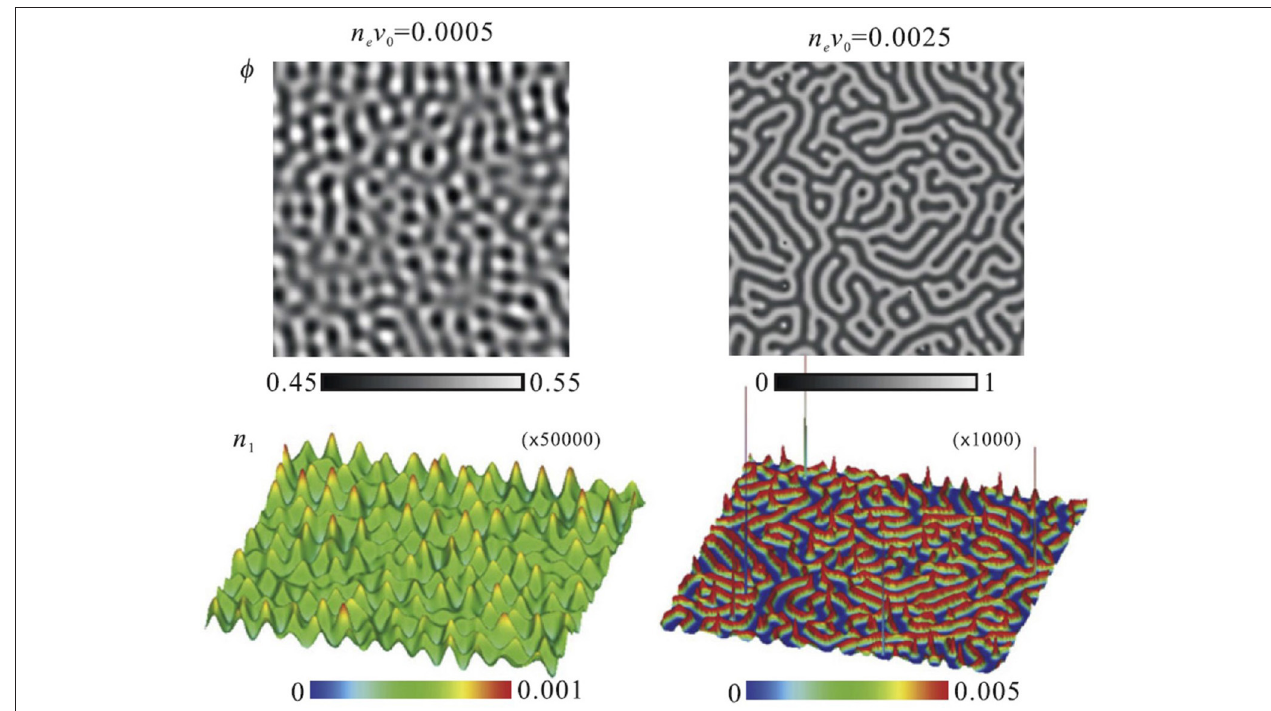
FIGURE 11 | Morphologies of concentration fluctuation (upper figures) and charge density (lower figures) in the charge-density-wave phase obtained by Araki and Onuki by numerical simulation. φ , n 1 , n e , and v 0 are the volume fraction of water in the mixture, the cation density, the average ion density, and the solvent molecular volume, respectively. The figure is reproduced from Araki and Onuki [10] with permission from Copyright 2009 IOP 1 Publishing Ltd.